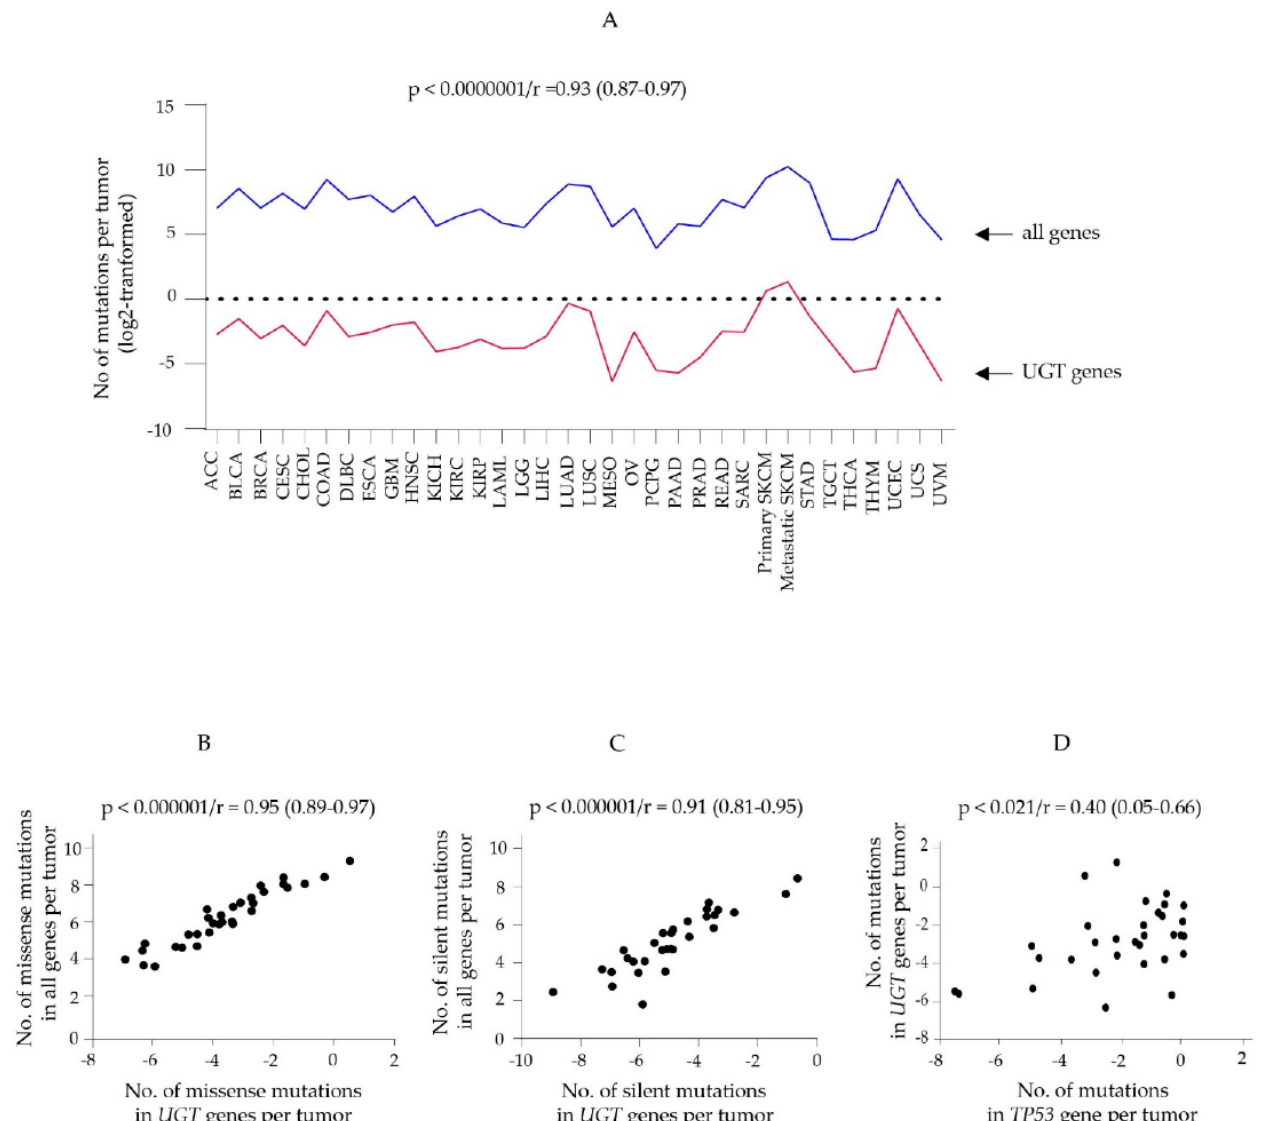
Figure 1. Assessment of the potential correlation between the numbers of mutations per tumor in UGT genes and in all protein-coding genes or TP53 gene across 33 TCGA cancer types. The numbers of mutations per tumor in all protein-coding genes, UGT genes or TP53 gene in 33 TCGA cancer types were log2 − transformed and subjected to Spearman ranking correlation analysis using GraphPad Prism (9.1.1). ( A – C ) A diagram shows the correlation analysis between the numbers of all mutations ( A ), missense ( B ) or silent mutations ( C ) in all genes and in UGT genes. ( D ) A graph shows the correlation analysis between the numbers of all mutations in UGT genes and TP53 gene. The p value, correlation coefficient (r) and 95% confidence interval of the correlation analyses are also shown. A p value of < 0.05 was considered statistically